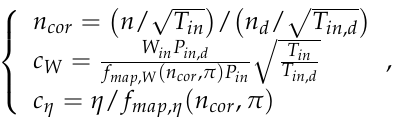
Figure 2. Compressor component inverse calculation.